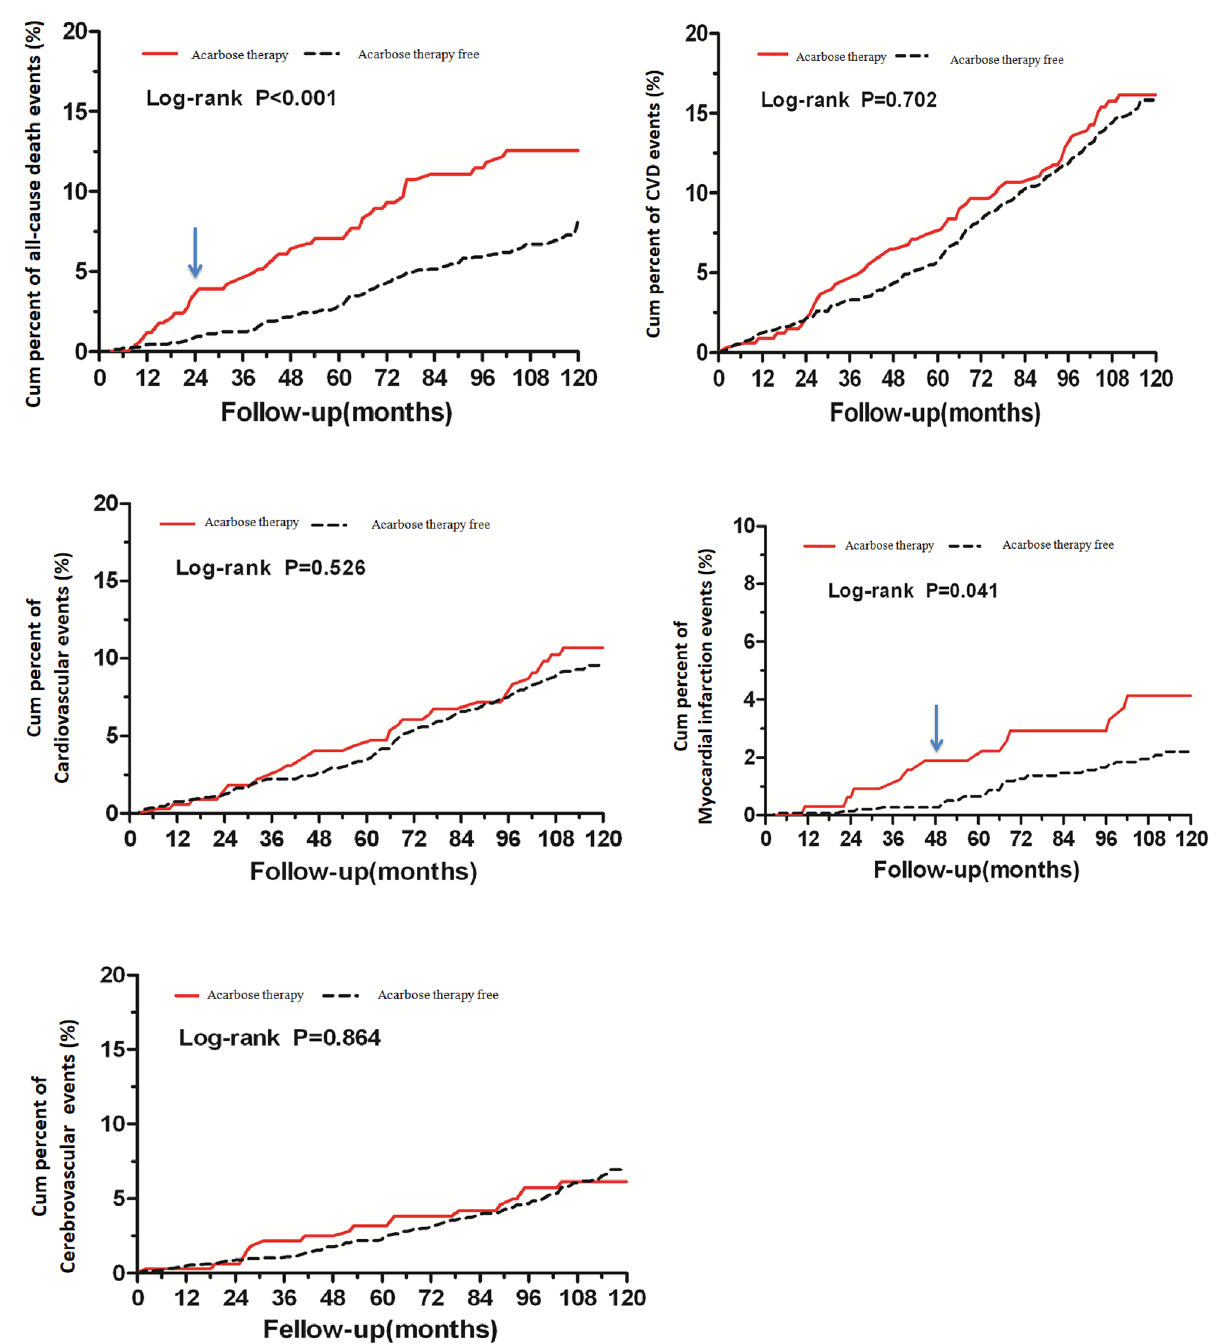
Figure 3. Cumulative incidences of all-cause end-point events during the follow-up between the two groups. The incidences of myocardial infarction (from the 4th year of follow-up) and all-cause death (from the 2nd year of follow-up) in patients who received acarbose therapy were significantly lower than that of acarbose therapy free